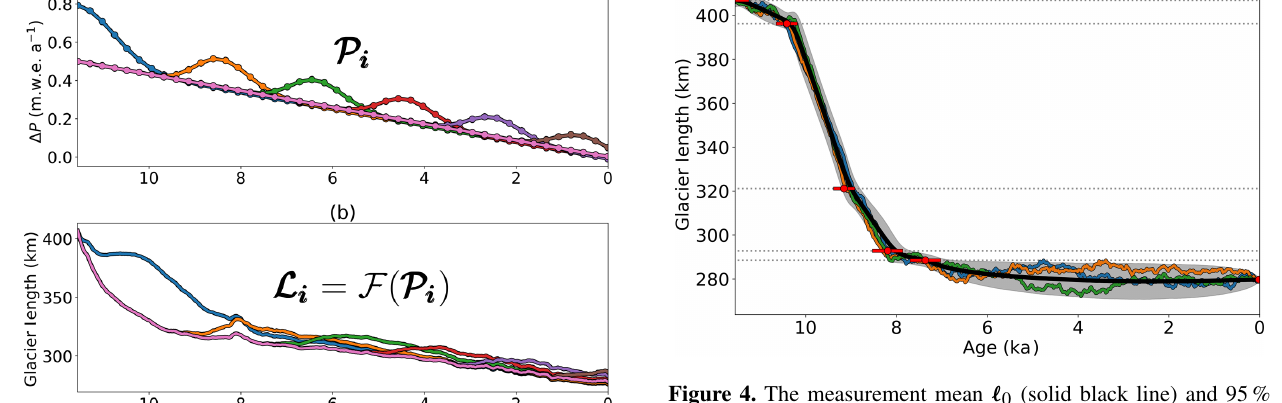
Figure 4. The measurement mean (cid:96) 0 (solid black line) and 95% confidence bands (gray shaded region) for the northern flow line are estimated by generating random retreat histories with the same mean moraine formation ages and variances as the observations. The green, blue, and orange lines represent four random plausible retreat histories. Red dots denote the estimated mean moraine for- mation ages, while red lines show 95% confidence